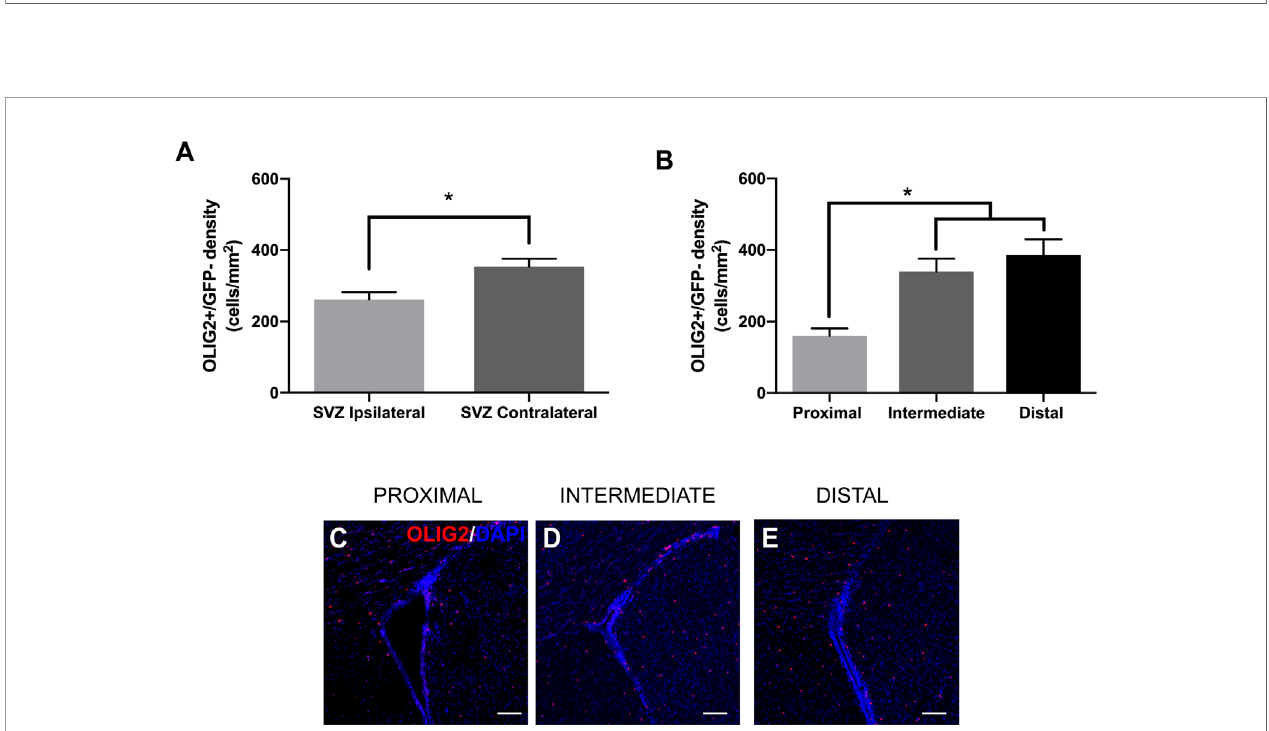
FIGURE 5 | LV-proximal GBM reduces the number of OLIG2+ progeny in the ipsilateral SVZ. (A) Quanti fi cation of OLIG2+ cell density in the ipsilateral and contralateral SVZ of all groups. (B) Quanti fi cation of OLIG2+ cell density in the SVZ ipsilateral to the tumor in LV-proximal, LV-intermediate, and LV-distal GBM mice. (C-E) Representative images of the ipsilateral SVZ in (C) LV-proximal (n = 7), (D) LV-intermediate (n = 5), and (E) LV-distal (n = 5) groups. Scale bar = 100 m m. Data are represented as mean ± SEM. * p < 0.05.